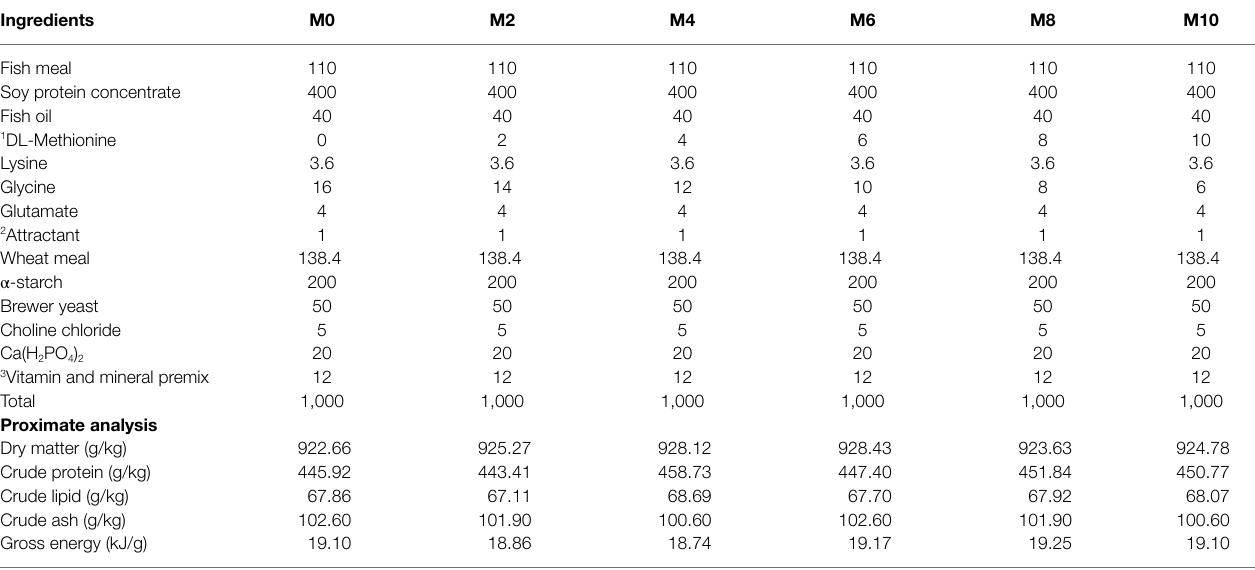
TABLE 1 | Composition of the six diets and their nutritive concentrations